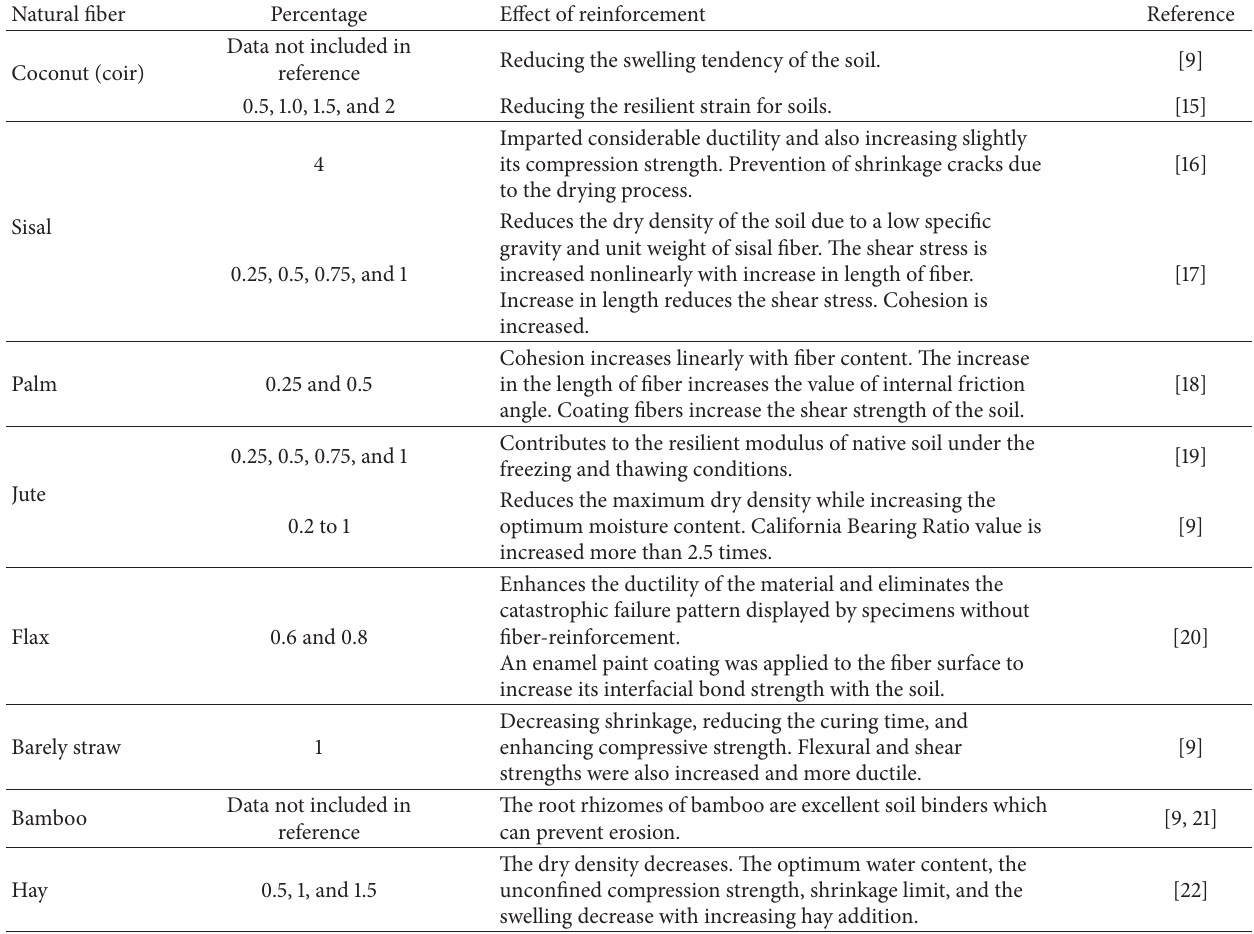
Table 1: Natural fibers used as reinforcement for modified